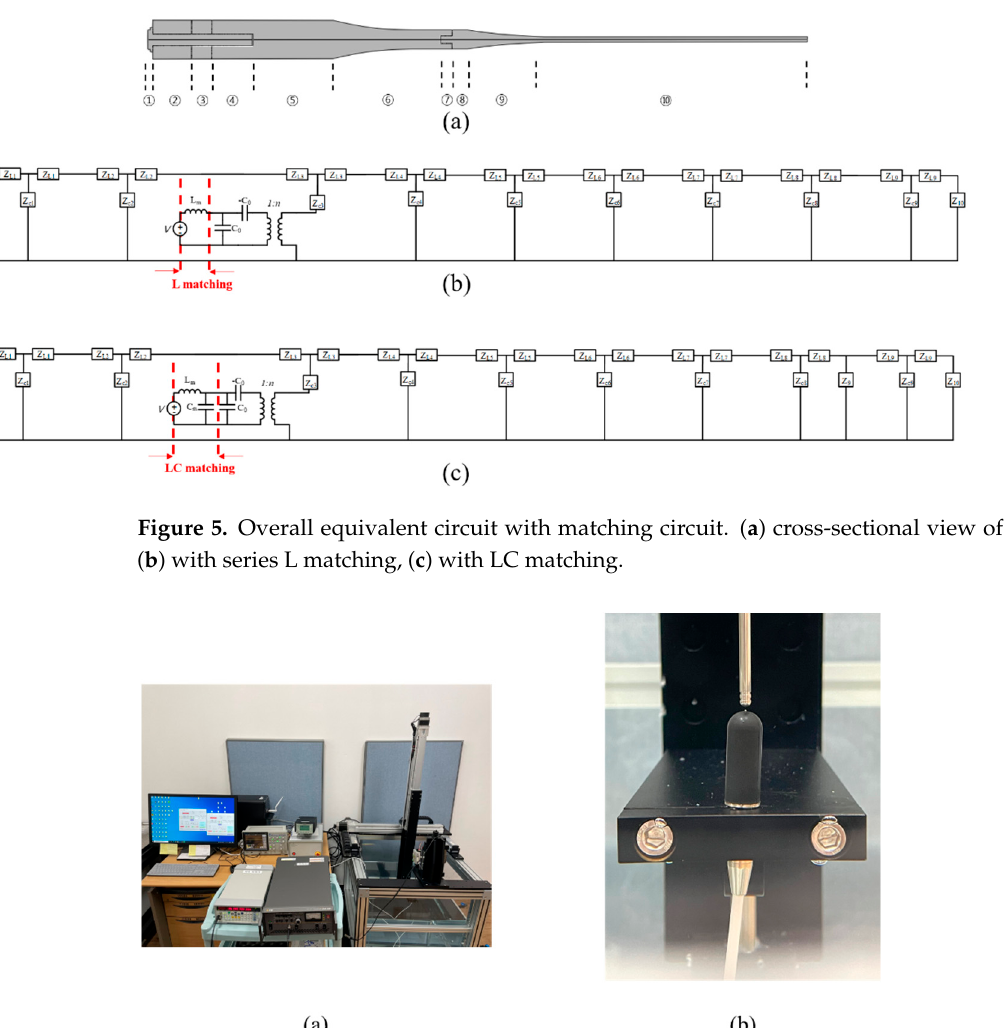
Figure 6b. The pressure is measured by the sensor with a resolution of 10 µ V/Pa and the